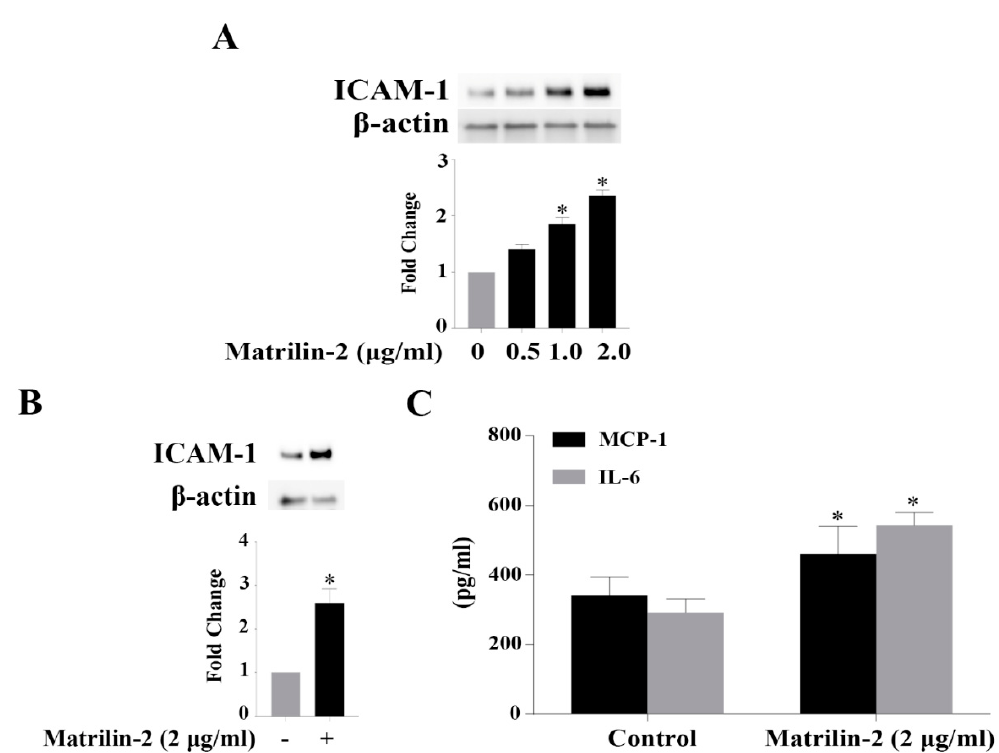
Figure 1. Matrilin-2 induces the inflammatory responses in human aortic valve interstitial cells (AVICs). Human AVICs were stimulated with different concentrations of recombinant matrilin-2 for 48 h. ( A ) Recombinant matrilin-2 has a dose-dependent effect on ICAM-1 expression in human AVICs. ( B ) Recombinant matrilin-2 (2.0 µg/mL) increases ICAM-1 levels. ( C ) Recombinant matrilin-2 promotes the release of MCP-1 and IL-6. Values are means ± SE. n = 5 experiments using distinct cell isolates; * P < 0.05 vs. control.